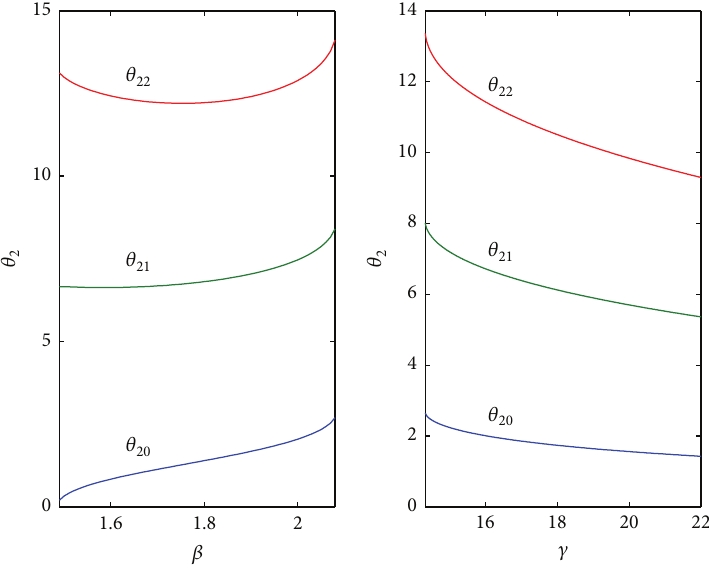
Figure 1: Crossing curves.